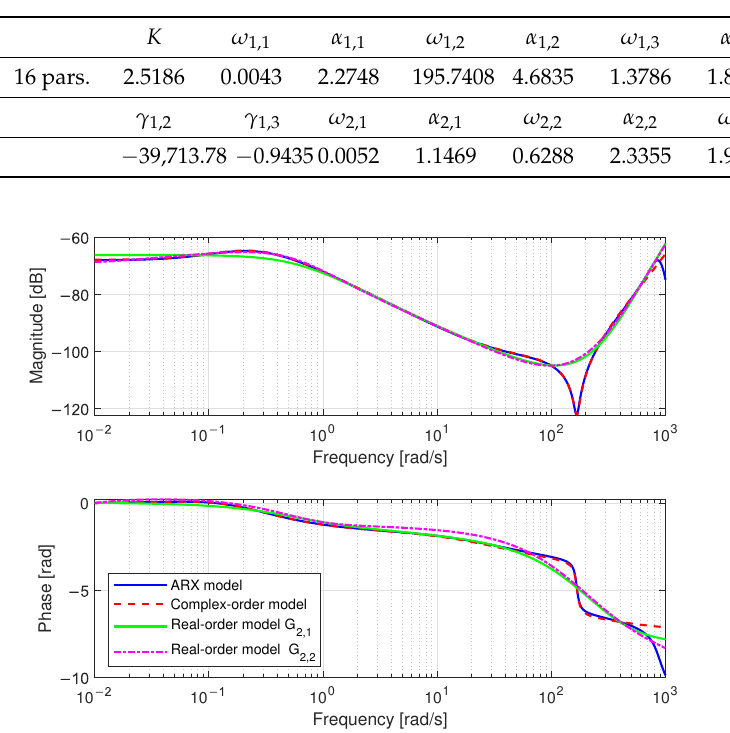
Figure 11. Comparison of the frequency responses of the fitted high-order ARX model, complex-order model, and the real-order models G 2,1 , G 2,2